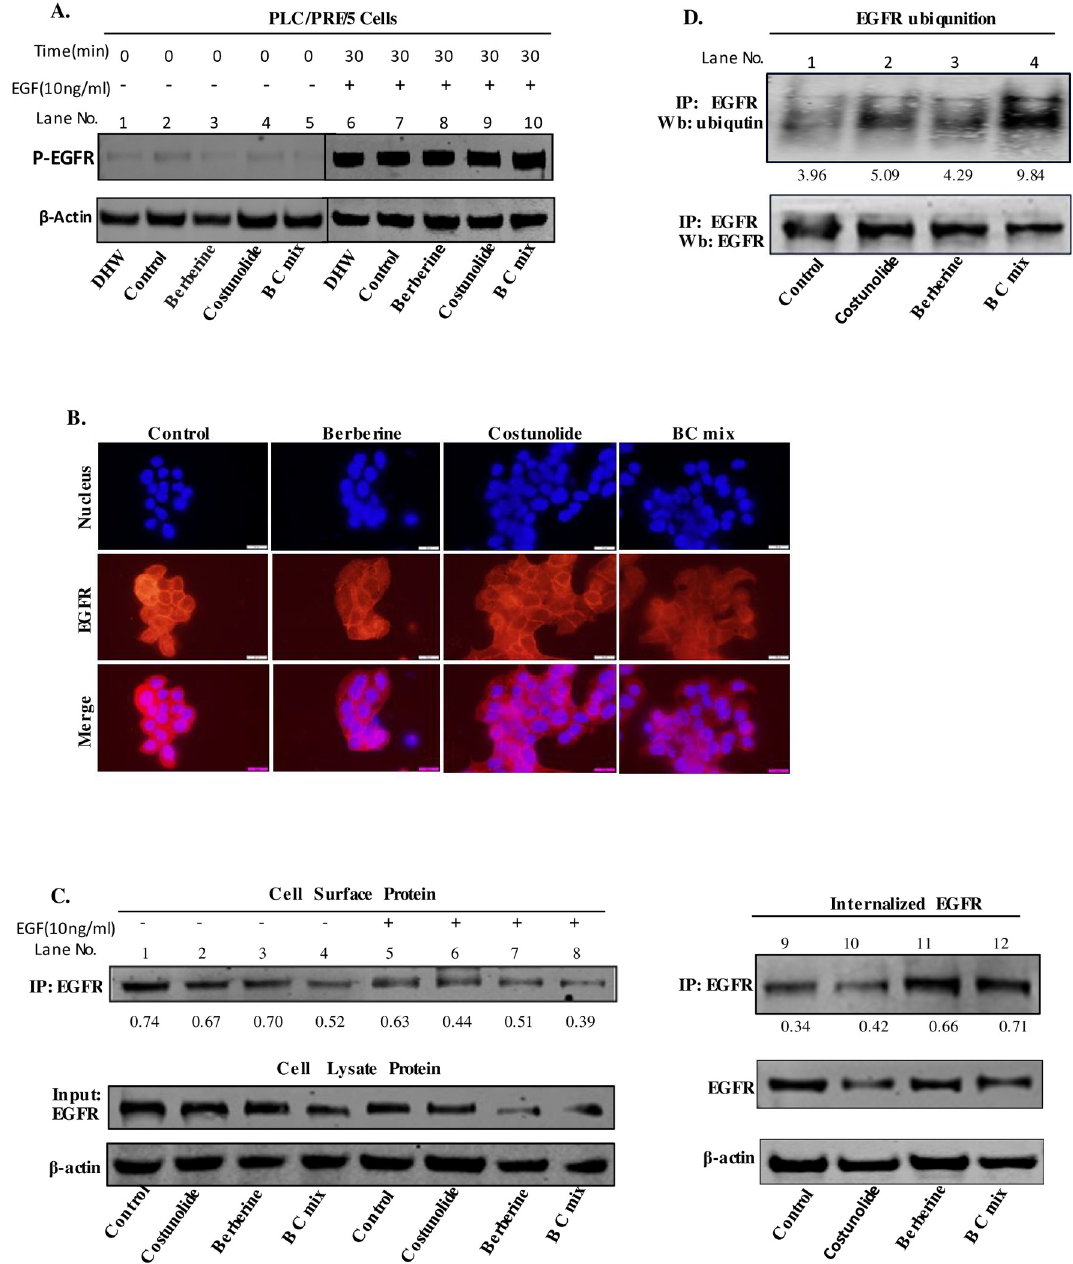
Fig 4. A, PLC/PFR/5 cells were serum-starved and incubated without (control) or with Berberine, Costunolide and BC mix for 24 hrs, and then stimulated by EGF (10ng/ml) for 30 mins. The expression level of P-EGFR in PLC/PRF/5 cells was examined by Western blot. B, EGFR on the surface of PLC/PRF/5 cells were examined by immunofluorescence after treated with Berberine, Costunolide and BC mix for 24 hrs, and then stimulated by EGF (10ng/ml) for 30 mins; C, PLC/PFR/5 cells were serum-starved and incubated without (control) or with Berberine, Costunolide, and BC mix for 24 hrs, and then stimulated by EGF (10ng/ml) for 30 mins. Proteins on cell surface were labeled with Sulfo-NHS-SS-Biotin and isolated by streptavidin and then analyzed by immunoblot detected EGFR (lane5- 8); The internalized cell surface proteins were isolated using Sulfo-NHS-SS-Biotin and MesNa and analyzed by immunoblot detecting EGFR (top panel) (lane9-12). D, PLC/PRF/5 cells were incubated without (control) or with Berberine, Costunolide, and BC mix for the indicated time periods. Ubiquitinated EGFR was examined via EGFR immunoprecipitation followed by immunoblotting with an ubiquitin antibody. The bands were quantified. The level of ubiquitinated EGFR was normalized to the immunoprecipitated EGFR. The relative density of the